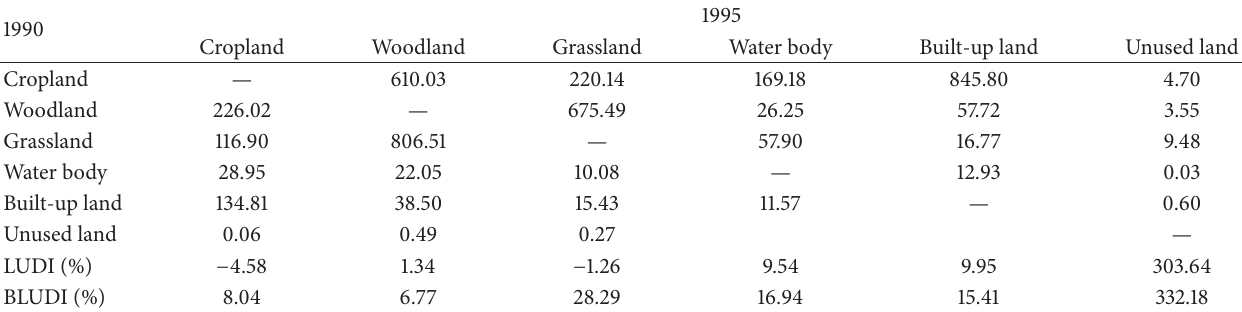
Table 1: Land use change detection matrix in the period of 1990–1995 (km 2 ).